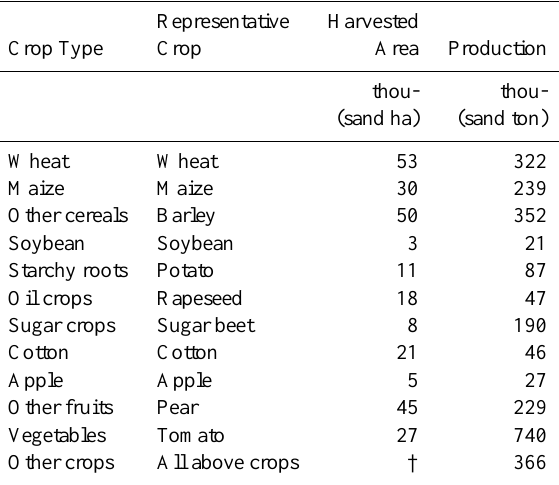
Table 1. Annual harvested area and crop production within the HRB